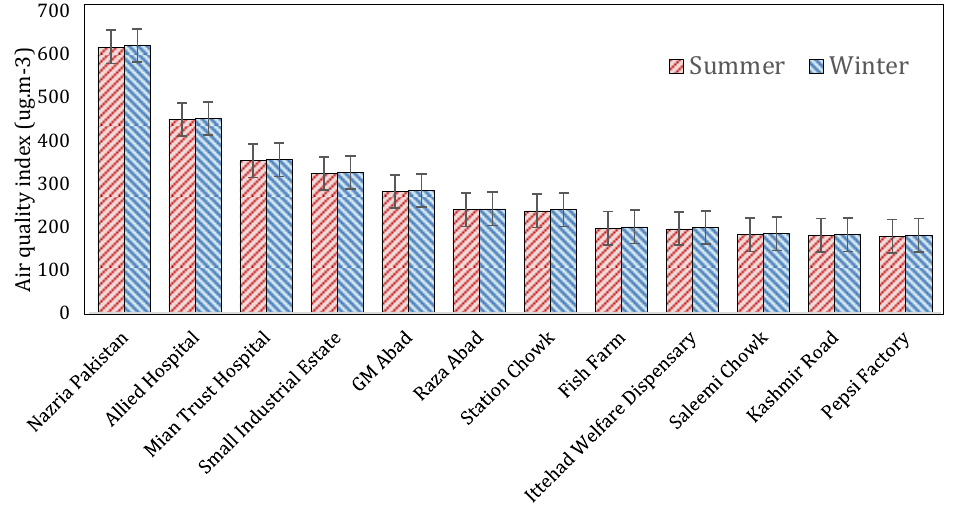
Figure 7. Air Quality Index (AQI) of Faisalabad city after analysis.